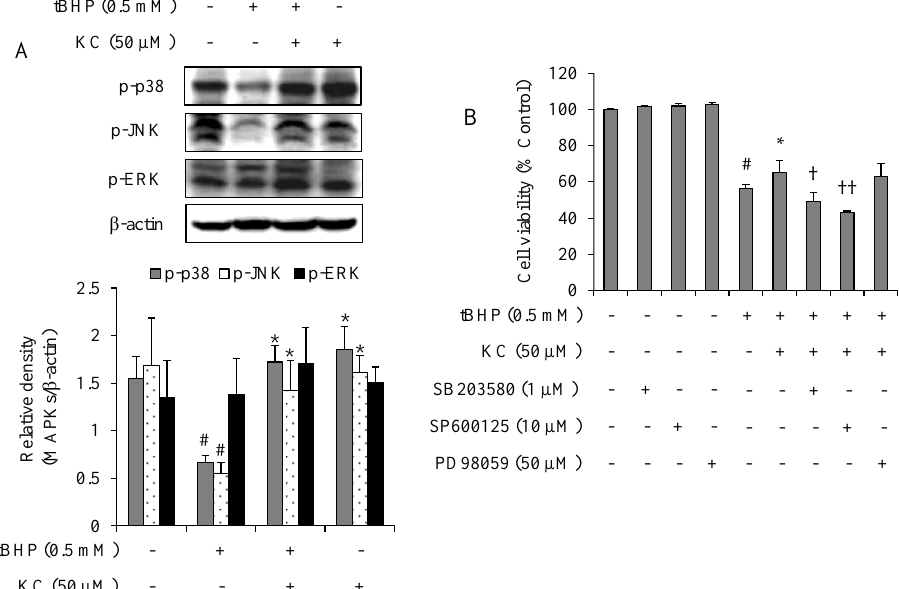
Figure 5. Effect of kushenol C on MAPKs expressions in tBHP-treated HEPG2 cells. ( A ) Cells were preincubated with or without KC for 1 h and then treated with or without 0.5 mM of tBHP for 12 h. p38, JNK, and ERK with their activated forms were investigated by Western blot assay and the band densities were analyzed using ImageJ analysis software, with respect to actin. ( B ) Cells were preincubated with KC at different concentrations and/or p38, JNK, and ERK inhibitors for 1 h and then treated with tBHP for 12 h. Cell viability was determined using EZ-Cytox reagent. Error bars represent the mean ± SD, # p < 0.001 vs. Control, * p < 0.05 vs. tBHP- only treated cells, † p < 0.01, †† p < 0.001 vs. tBHP plus KC treated cells.